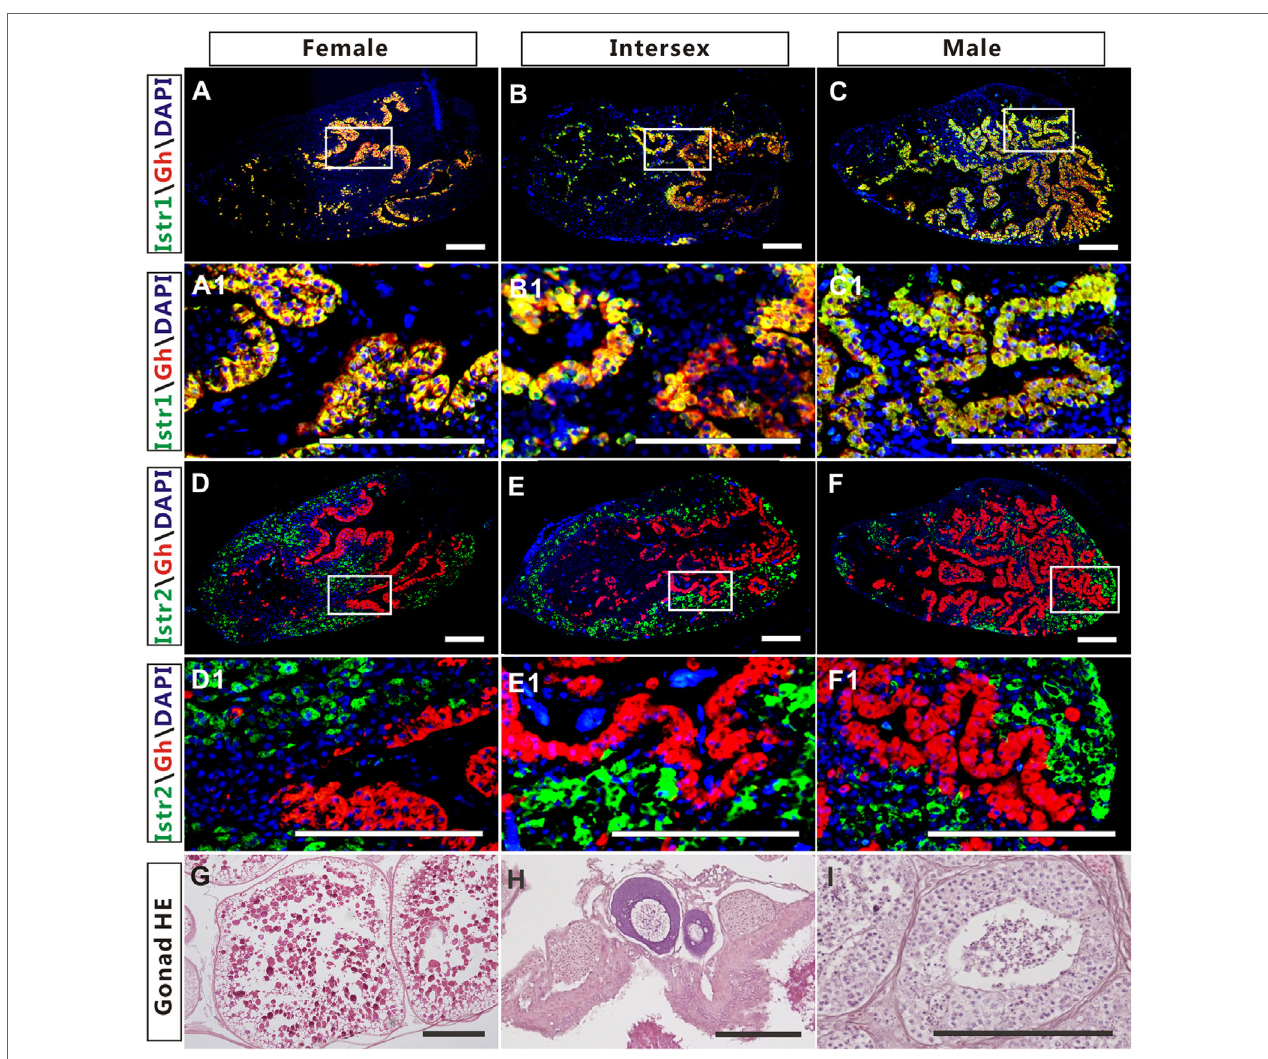
FigUre 5 | The co-localization of immunoreactive isotocin (Ist) receptor 1 (Istr1) (green) or Istr2 (green) with growth hormone (Gh) (red) in the pituitary of female, intersexual, and male ricefield eels. The rabbit antiserum against Istr1 (1:500) or Istr2 (1:500) and mouse antiserum against Gh (1:800) were used as primary antisera. The secondary antibodies were 1:500 diluted Alexa Fluor 488-labeled goat anti-rabbit immunoglobulin G (IgG) (H + L) for Istr1 and Istr2, and 1:500 diluted Cy3-labeled goat anti-mouse IgG (H + L) for Gh. DAPI was used to stain the nuclei blue. The images were observed and captured with a confocal microscope under the same conditions. (a1–F1) are higher magnification of (a–F) , respectively. The overlapping of the red with the green color generated a yellow color. (g–i) : HE-stained gonads of the experimental fish at female, intersexual, and male stages, respectively. Scale bar is 50